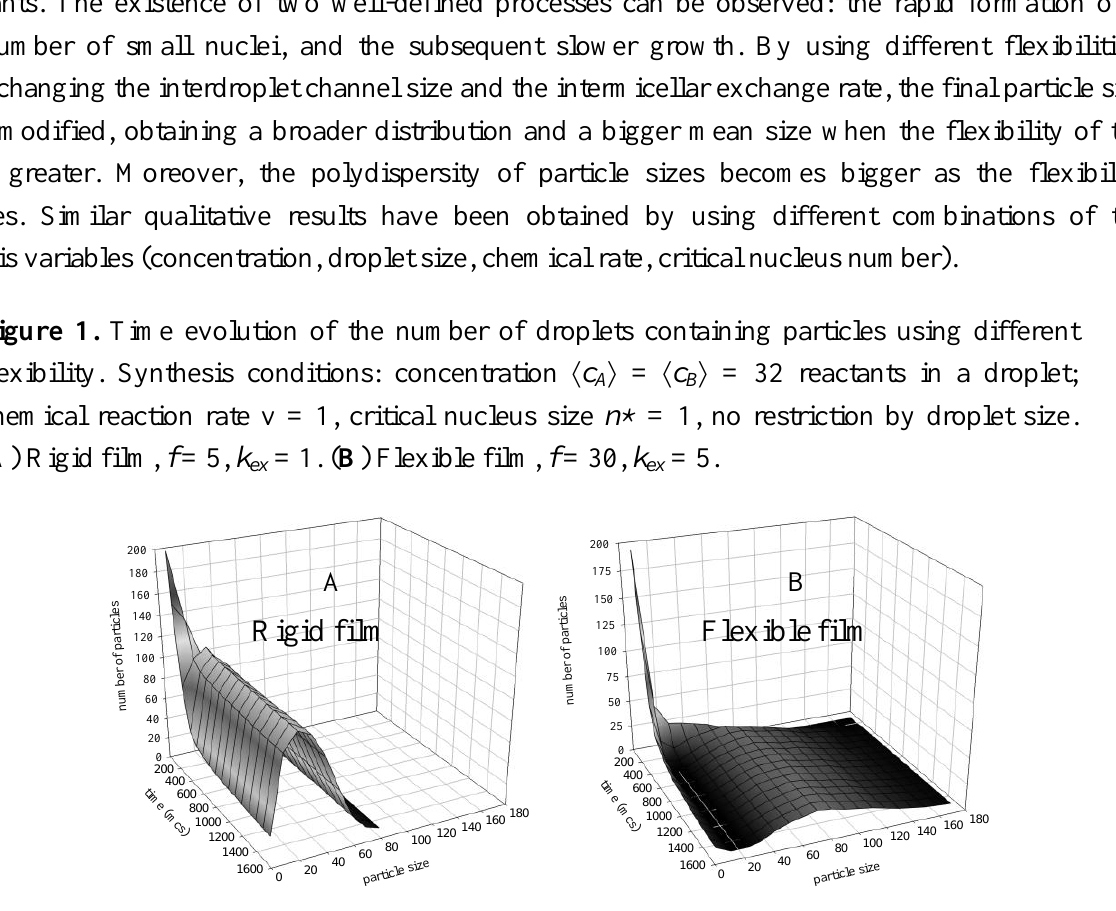
 =  c  = 32 reactants in a droplet; A B